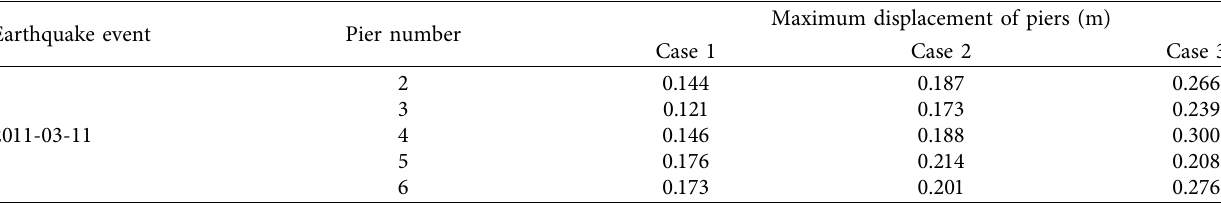
Figure 10: Acceleration amplification factor spectrum of the seabed or surface in the three earthquakes. (a) 2011-03-11. (b) 2012-03-14. (c) 2019-06-18. Table 5: Maximum longitudinal relative displacement of